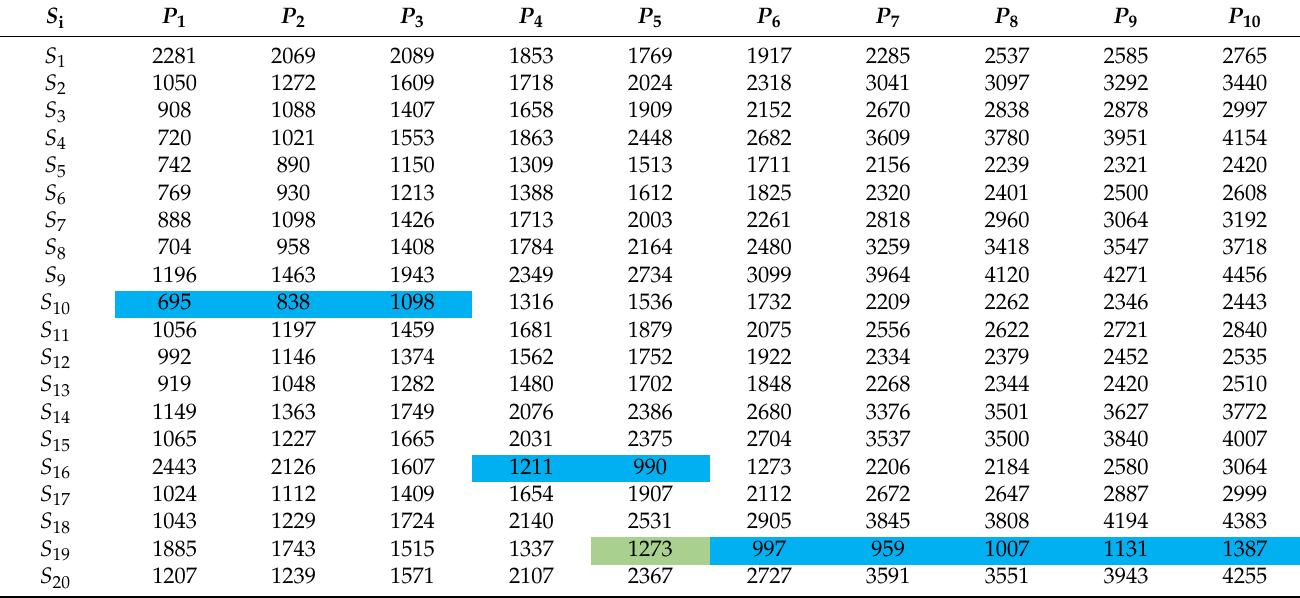
Table 4. Unit discount costs C ji (measured by SLTs) calculated manually using the traditional